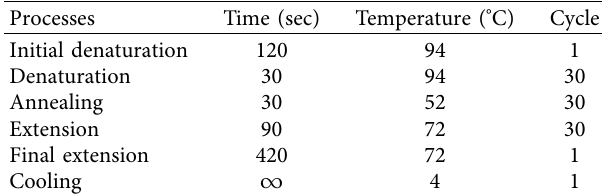
Table 1: PCR protocol